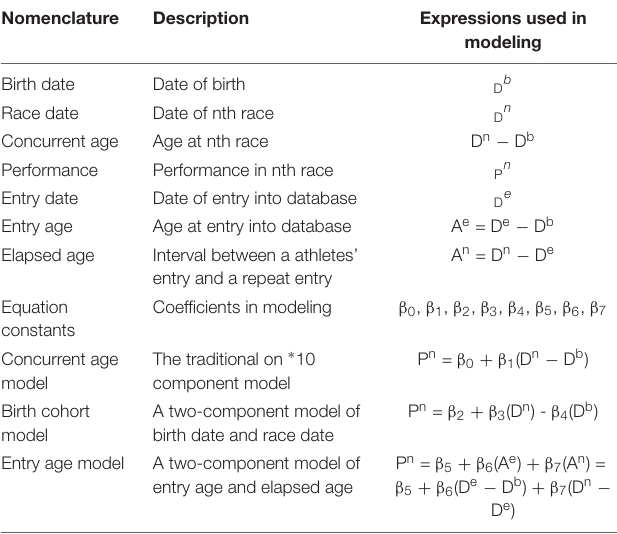
TABLE 1 | Nomenclature and expressions used in